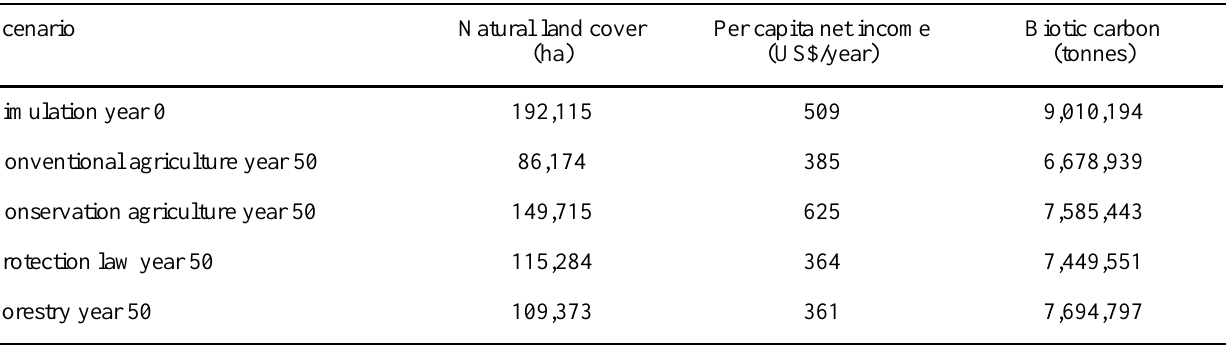
Table 2 . Indicator status at that start of the simulation and after 50 years under the four land use